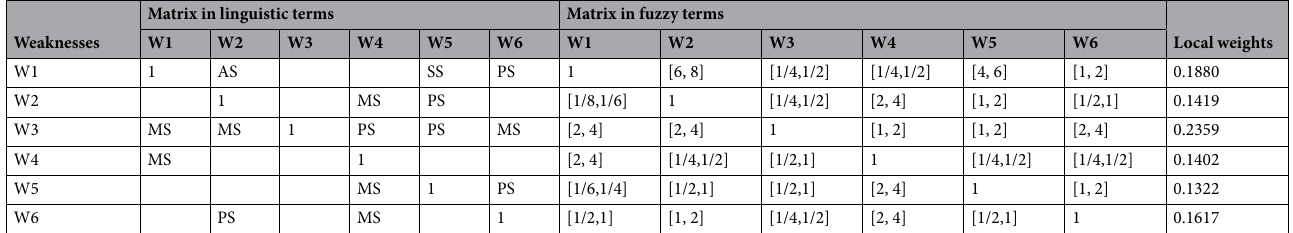
Table 5. Evaluation criteria of the Weaknesses. (C.R. = 0.052).